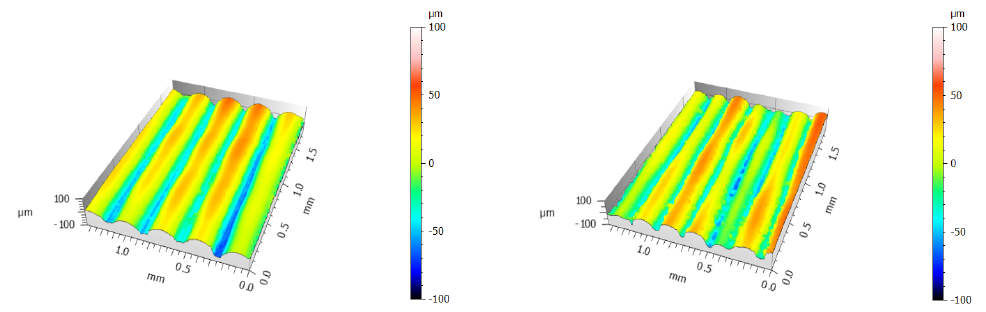
Figure 18. Roughness scan of vertical surface of reference parts. Prusa ( left ) and RotBot ( right ). Figure 18 illustrates the ripple and the roughness of the vertical surfaces with the horizontal layers. The measured values are shown in Table 2. It reveals that both reference parts have very similar